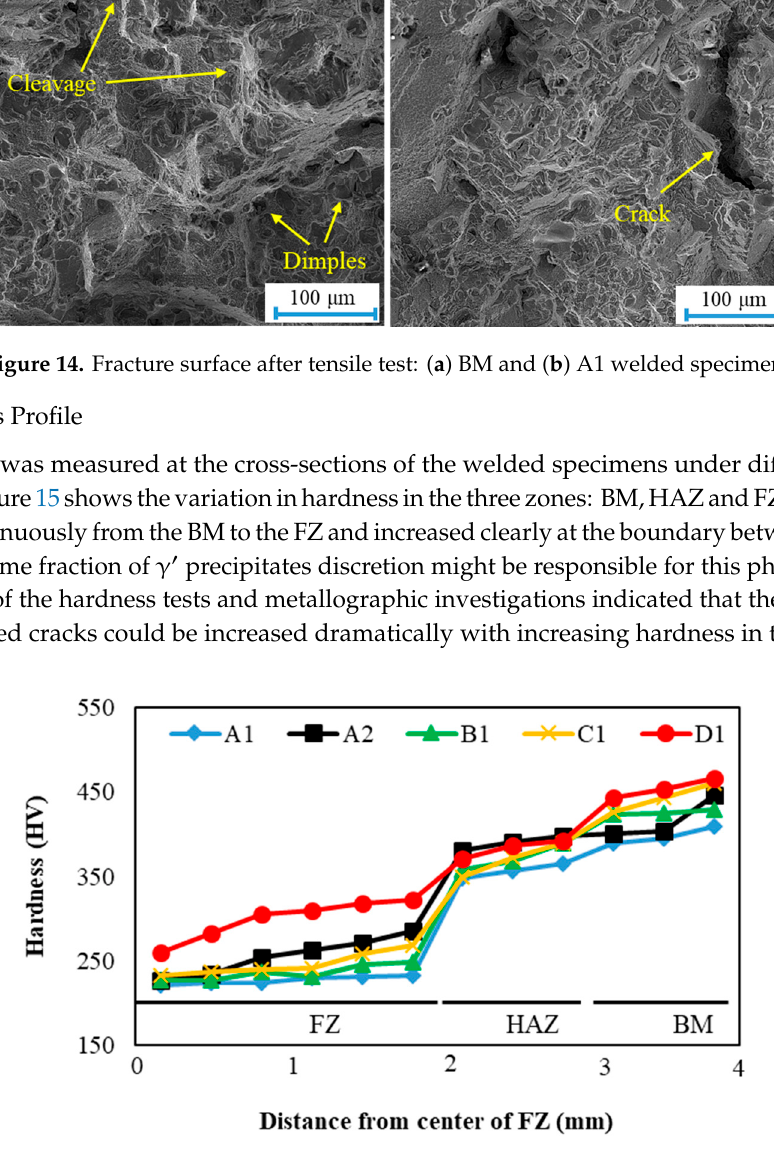
Figure 15. Changes in hardness profile in the welding zone.